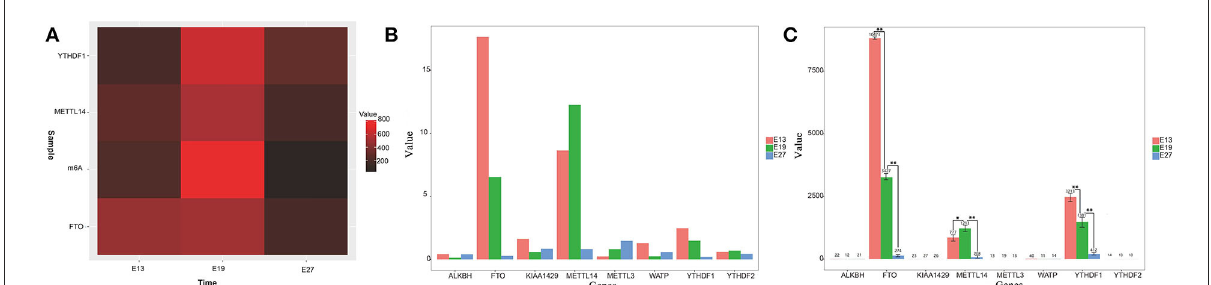
FIGURE1 Gene expression levels of m6A methylation enzymes in different stages. (A) Heatmap of m6A modification levels of E13, E19, and E27 in duck embryonic breast muscles. (B) Gene expression levels of m6A methylation enzymes at E13, E19, and E27 from RNA-seq data. (C) Detection of gene expression levels of m6A methylation enzymes at E13, E19, and E27 detected by qRT-PCR. Statistically significant differences are indicated by * p ≤ 0.05, ** p ≤ 0.01.